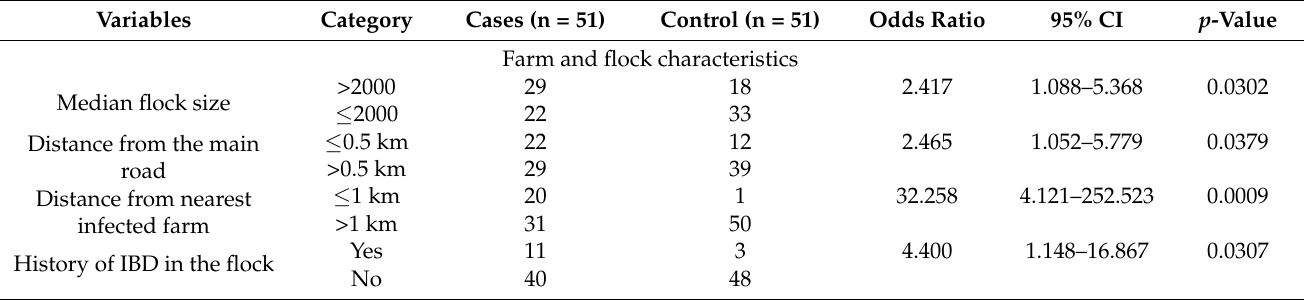
Table 1. Result of univariable logistic regression analysis showing significant variables on the cut-off value of p ≤